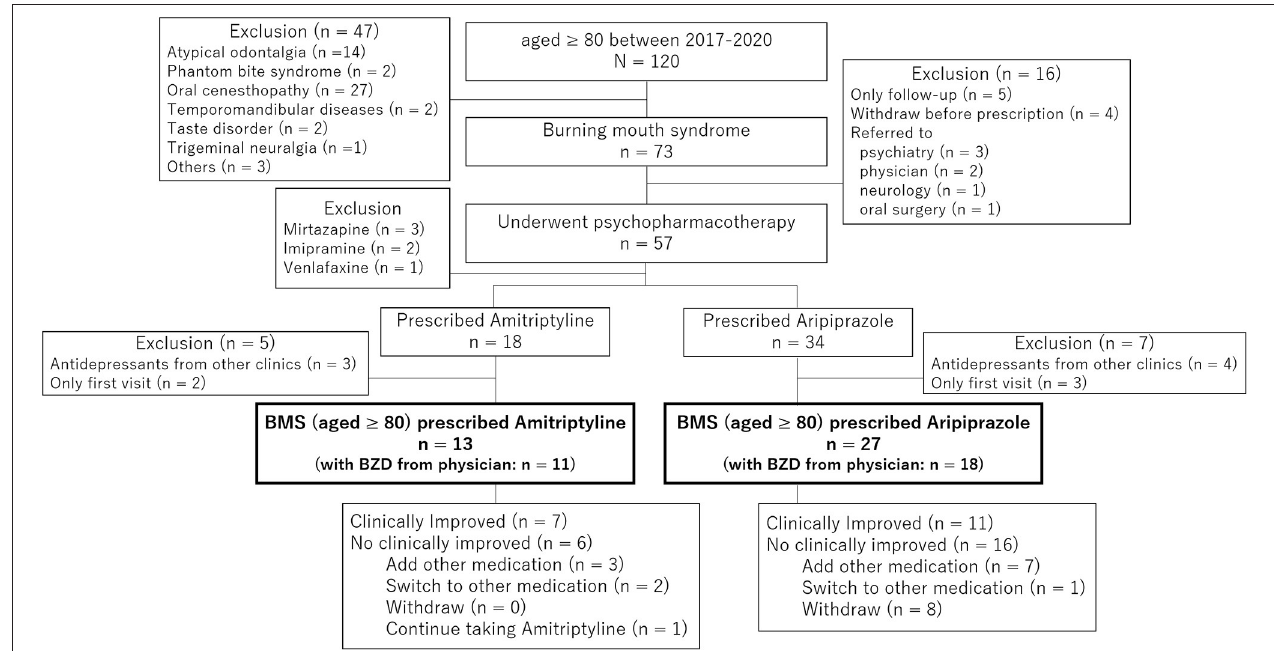
FIGURE 1 | The chart of patients involved in the present study. In 73 patients with burning mouth syndrome (BMS) whose age was 80 or over, 57 patients underwent psychopharmacotherapy that include 18 patients who were prescribed amitriptyline and 34 patients who were prescribed aripiprazole. After exclusion of the duplicated prescriptions from other clinics and withdrawal, 13 patients who were prescribed amitriptyline and 27 patients who were prescribed aripiprazole were involved in the present